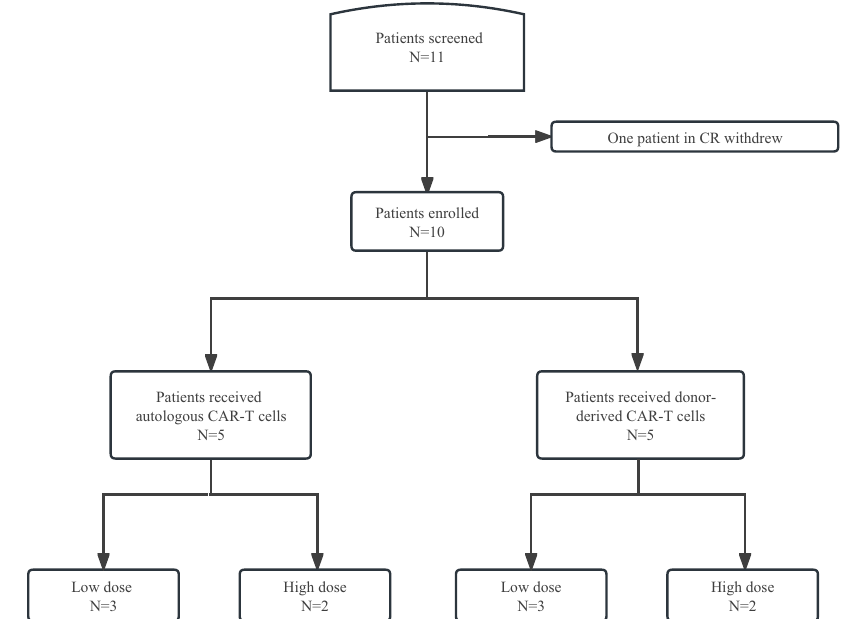
Fig. 1 Consort diagram of patient fl ow. Ten patients were enrolled in the study and underwent leukapheresis. Anti-CD7 CAR-T cells were derived from patients or their donors and infused into all patients at a low dose (1 × 10 6 /kg, n = 5) or a high dose (2 × 10 6 /kg, n = 5).